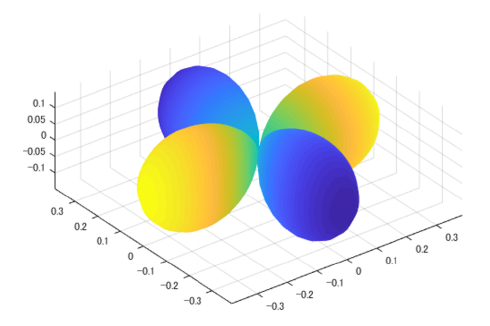
Figure 7. Shapes of SH function at order n = 2 and degree m =